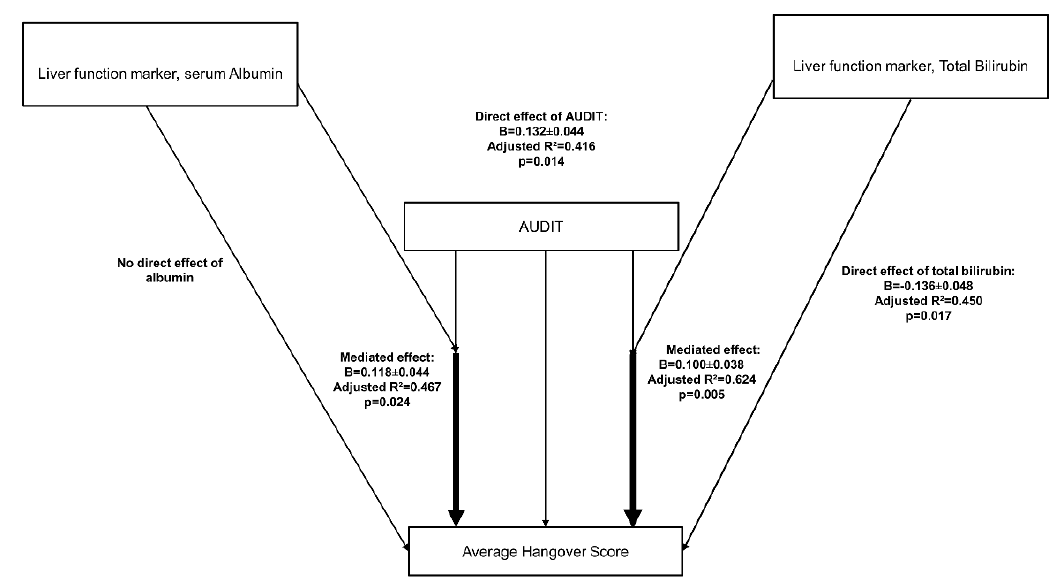
Figure 5. Schema of the effects of liver status (impaired liver function) and drinking severity on hangover symptomology. Liver function markers serum albumin and serum total bilirubin showed potential mediating roles in the effects of AUDIT on hangover symptoms.